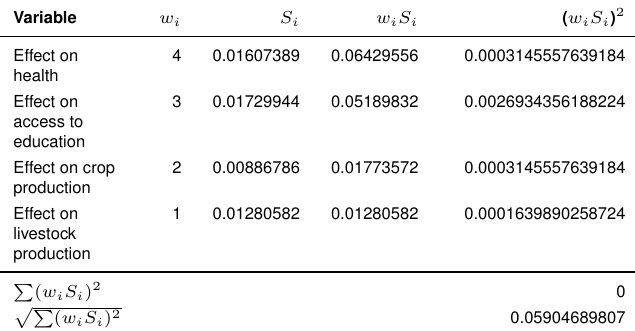
Table 3. Calculation of accuracy using uncertainty